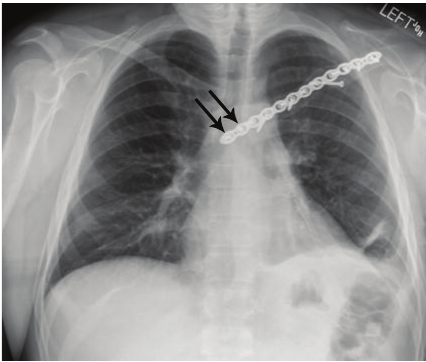
Figure 3: Fixation of both fractures using a reconstruction plate with screws. The arrows indicate the two screws placed in the sternum.